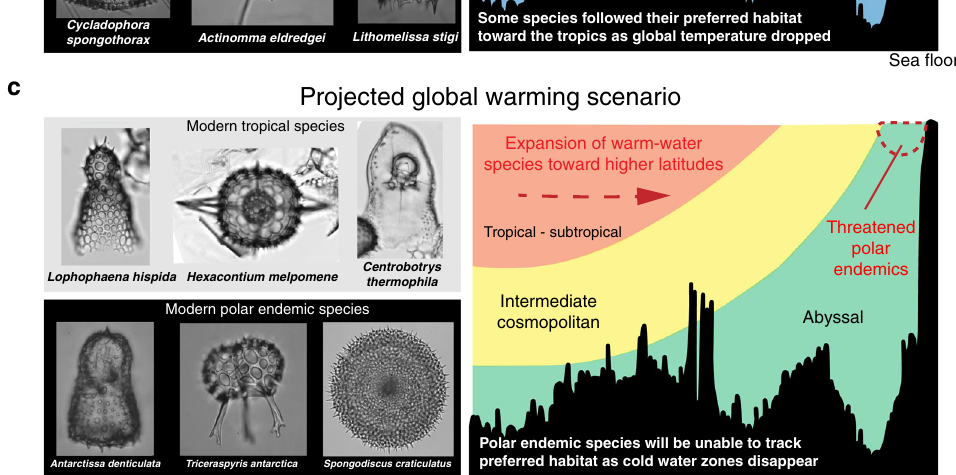
among samples that vary in community structure or sample size 34 . Extrapolated species richness had a mean of 485 (±36) over the last 10 Ma (Fig. 2a). For comparison to previous work, we